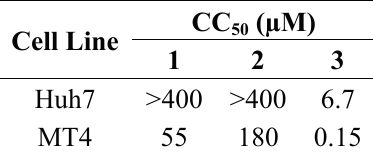
Table 2. Cytotoxic activities of compounds 1 – 3 against the Huh7 and MT4 tumor cell lines.